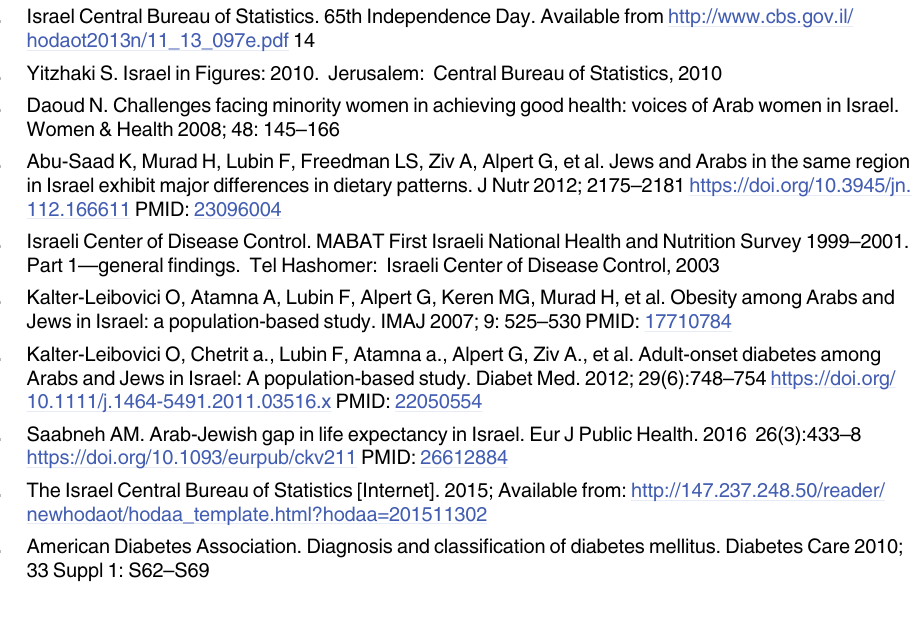
S3 Table. HDL-cholesterol information. Information on HDL-C was not available for 15.8% of Arab participants and 19.2% of Jewish participants. S4 Table. Systolic blood pressure. Information on systolic blood pressure was not available for 4.3% of Arab participants and 10.9% of Jewish participants. S5 Table. Diastolic blood pressure. Information on diastolic blood pressure was not available for 4.3% of Arab participants and 10.8% of Jewish participants. NA = Not available Total dia- betes: prevalent diabetes by 2007, plus cumulative incident diabetes between 2008–2011. S1 File. Formula for the calculation of the weighted incidence